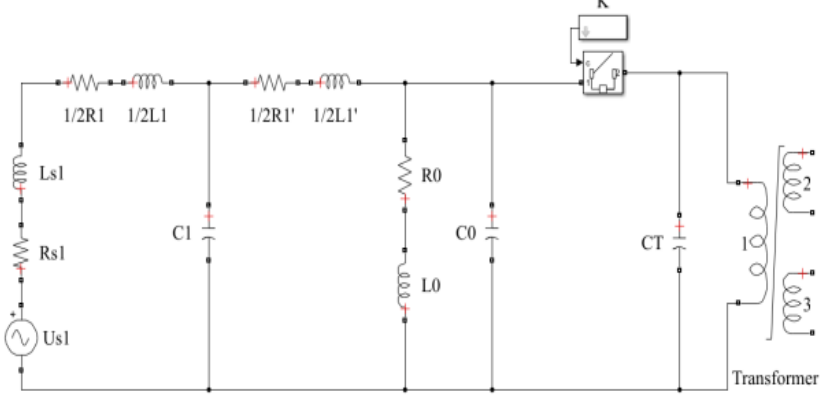
Figure 7. Simulation model of closing and opening of the vehicle-mounted circuit breaker.